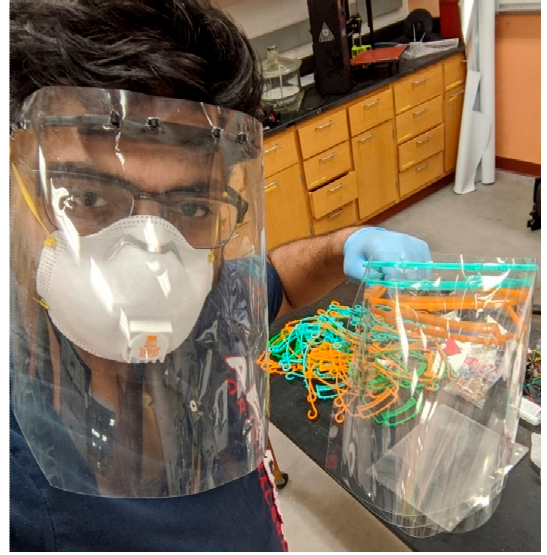
Figure 2. Michigan Tech student volunteer, Bharth Lavu, with 3-D printed open source face shields he fabricated on open source 3-D printers for use in local hospitals during the COVID-19 pandemic.